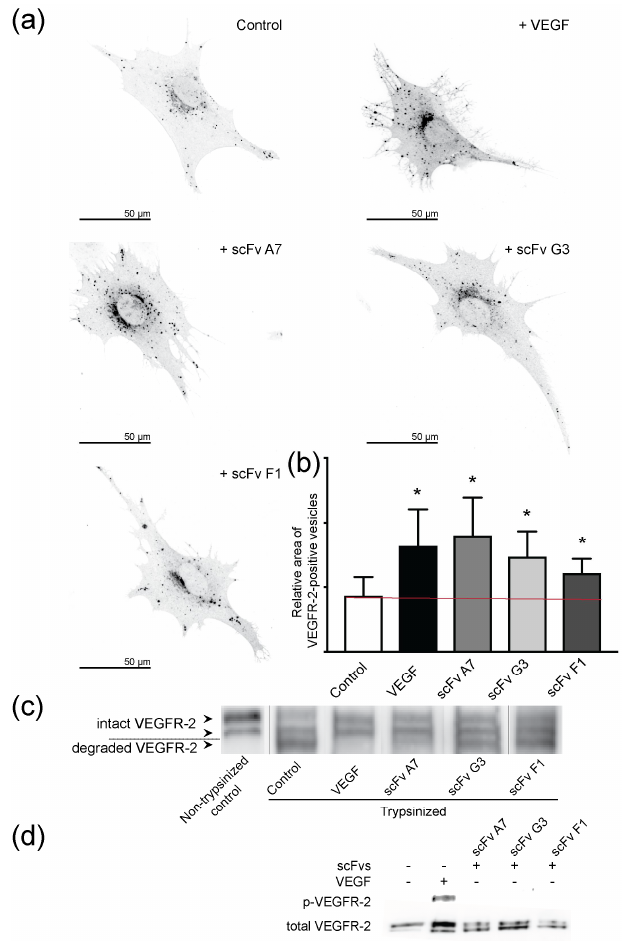
Figure 5. VEGF and scFvs promote VEGFR-2 internalization. ( a ) Immunostaining of VEGFR-2 expressing PAE-KDR cells show receptor internalization following VEGF or scFv administration. PAE-KDR cells were fixed and stained for 45 min after addition of VEGF or scFvs; ( b ) Area of VEGFR-2 positive vesicles relative to total cell area was analyzed by Squassh. Statistical data analysis was performed using GraphPad Prism 7. Data show representative images of 25 independent samples. Error bars represent ± SD. The statistical significance based on a Student’s t -test is indicated by * representing p < 0.05. The red line references non-stimulated control; ( c ) Western blot analysis of control and trypsin-treated cells using VEGFR-2-specific antibody. Cells were treated with VEGF or scFvs for 45 min. Top two arrows on the left of the blot indicate bands representing intact receptor, bottom arrow points to band of degraded receptor. ( d ) Kinase assay. SDS-PAGE gel shows kinase activity of VEGFR-2 determined with phospho-tyrosine-specific antibody in PAE-KDR cells. As controls we showed non-stimulated and VEGF-stimulated kinase activation. Bottom row shows total level of VEGFR-2 for the same gel.